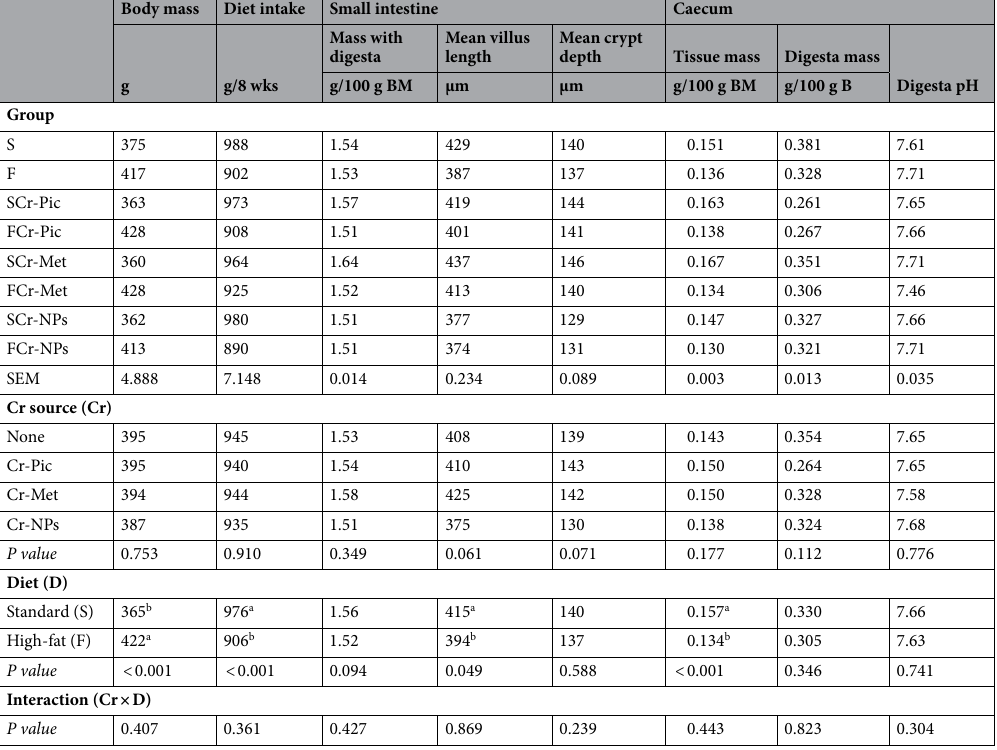
Table 1. Final body mass, dietary intake, and small intestinal and caecal parameters of rats fed experimental diets. S—Rats were fed a standard diet; F—rats were fed a high-fat, low-fibre diet; SCr-Pic—rats were fed S diet supplemented with 0.3 mg Cr/kg BW from chromium(III) picolinate; FCr-Pic—rats were fed F diet supplemented with 0.3 mg Cr/kg BW from chromium(III) picolinate; SCr-Met—rats were fed S diet supplemented with 0.3 mg Cr/kg BW from chromium(III)-methionine; FCr-Met—rats were fed F diet supplemented with 0.3 mg Cr/kg BW from chromium(III)-methionine; SCr-NPs—rats were fed S diet supplemented with 0.3 mg Cr/kg BW from nano-sized chromium; FCr-NPs—rats were fed F diet supplemented with 0.3 mg Cr/kg BW from nano-sized chromium. a,b Mean values within a column with